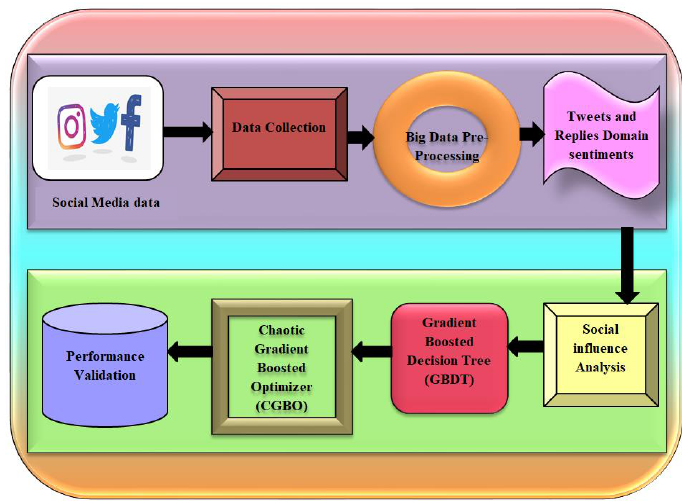
Figure 1. Block diagram of the Proposed GBDT-CGBO method.